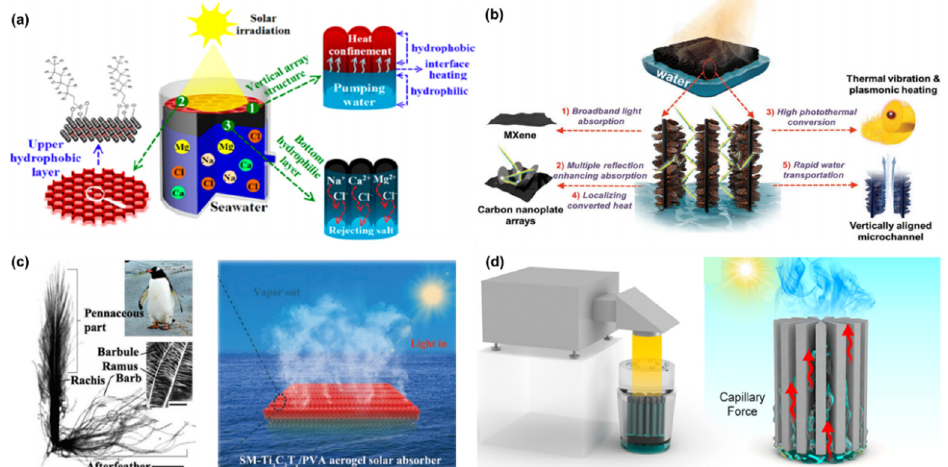
Figure 16. ( a ) Schematic illustration of a solar steam generation system and the salt resistance strategy based on a Janus-type MXene aerogel. ( b ) Schematic illustration of the solar-vapor generation from the solar absorber of MXene foam decorated with vertical arrays of 2D carbon nanoplates with embedded Co nanoparticles. ( c ) Photograph and optical microscope image showing a penguin down-feather (left); and schematic illustration of MXene/PVA aerogel with this microstructure for solar-powered water evaporation. ( d ) Schematic illustration of the radial MXene aerogel, photothermal evaporation device, and the capillary force in the aligned channels for water transportation. ( a ) is reproduced with permission from ref. [50]. Copyright 2019, American Chemical Society. ( b ) is reproduced with permission from ref. [160]. Copyright 2020, Wiley-VCH. ( c ) is reproduced with permission from ref. [110]. Copyright 2022, Wiley-VCH. ( d ) is reproduced with permission from ref. [53]. Copyright 2022, American Chemical